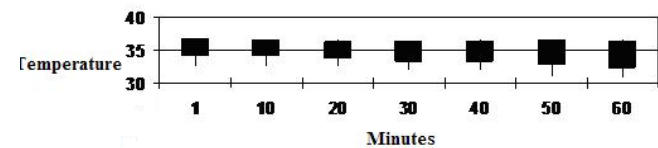
FIGURE 3 - Temperature during transoperatory